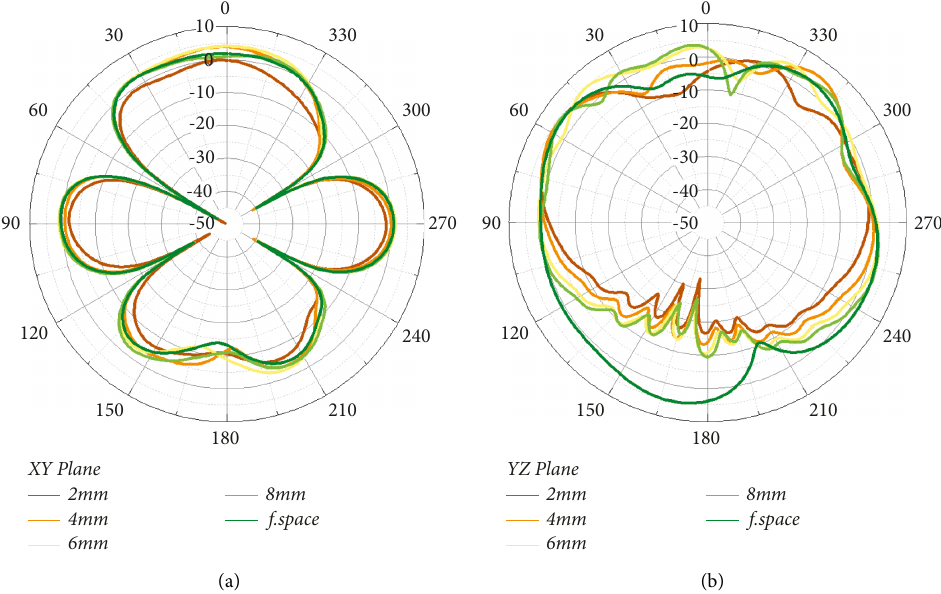
Figure 42: Radiation patterns of the1x2 array antenna for different distances (a) on XY plane and (b) on YZ